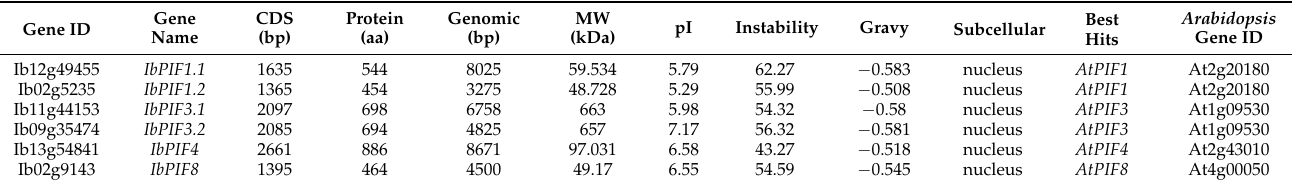
Table 1. Characterization of IbPIFs in sweet potato.